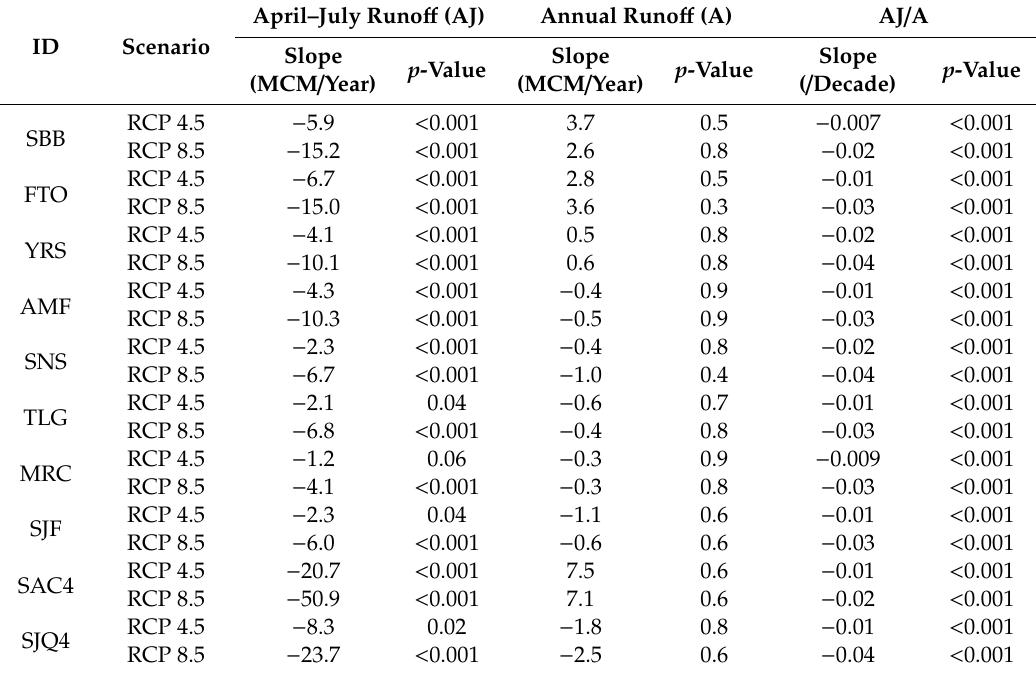
Table 4. Trend slope and corresponding p -values for mean projections on April–July and annual runoff.